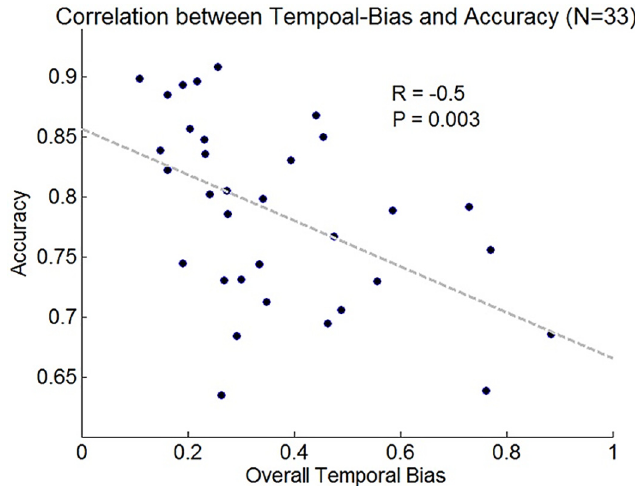
Fig 6. Inter-subjective correlation between temporal-bias and